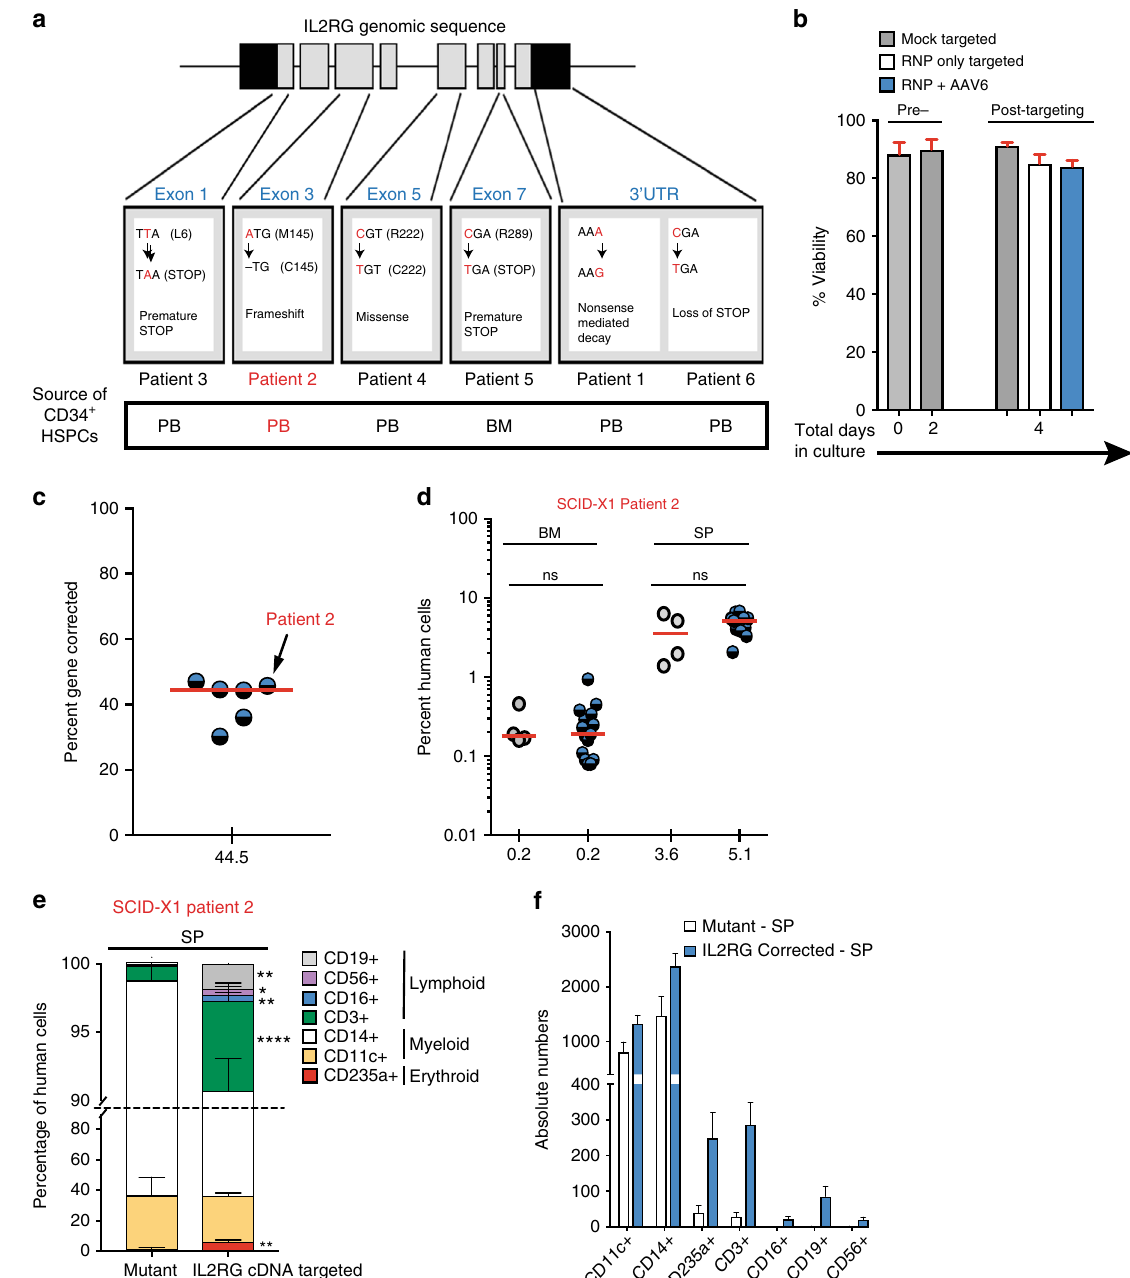
Fig. 4 In vivo rescue of SCID-X1 mutation. a Genomic mapping and description of SCID-X1 mutations. b Percent viability determined at indicated days pre- and post- targeting. Mock (nucleofected only), RNP (nucleofected with RNP only), RNP + AAV6 (nucleofected with RNP and transduced with AAV6-based IL2RG corrective donor). Shown is data for mobilized peripheral blood CD34 + HSPCs ( n = 5). c Medium scale (1.0 × 10 6 cells) ex vivo genome targeting frequencies of frozen mobilized peripheral blood SCID-X1, at day 2 (blue-black circles, n = 6). Arrow shows 45% genome targeting of SCID-X1 patient 2 derived CD34 + HSPCs. d Human cells engraftment analysis at week 17 after intra-hepatic (IH) delivery of IL2RG cDNA targeted (blue-black circles, n = 15) or mutant CD34 + HSPCs (gray circles, n = 4). e Percent cellular composition of the lymphoid, myeloid, and erythroid lineage derived from IL2RG corrected or mutant CD34 + HSPCs. CD3 + : **** p < 0.0001, CD56 + : * p = 0.0146, CD16 + : ** p = 0.0013, CD19 + : ** p = 0.0015, CD235a + : ** p = 0.0022 (Welch ’ s t- test). RNP ribonuclearprotein. f Absolute numbers derived from ( e ). Source data are available in the Source Data fi